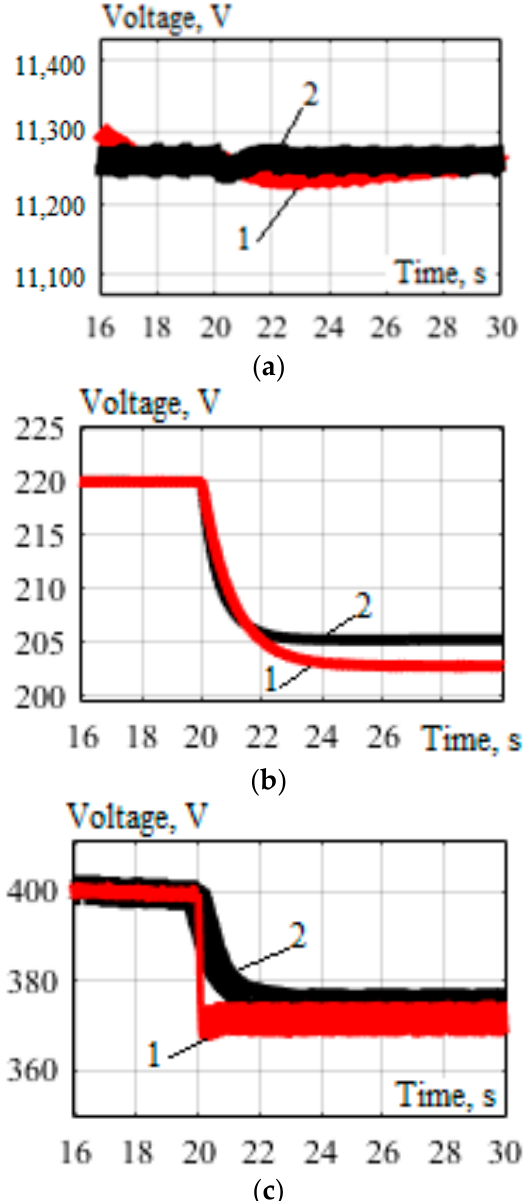
Figure 12. Time dependencies for voltages after connection of a heavy load in the 220V grid: ( a ) on the HV side of the PR; ( b ) on the LV side of the PR (DC grid); ( c ) on the LV side of the PR downstream the inverter (in the AC grid); 1—non-regulated PRs; 2—regulated PRs .